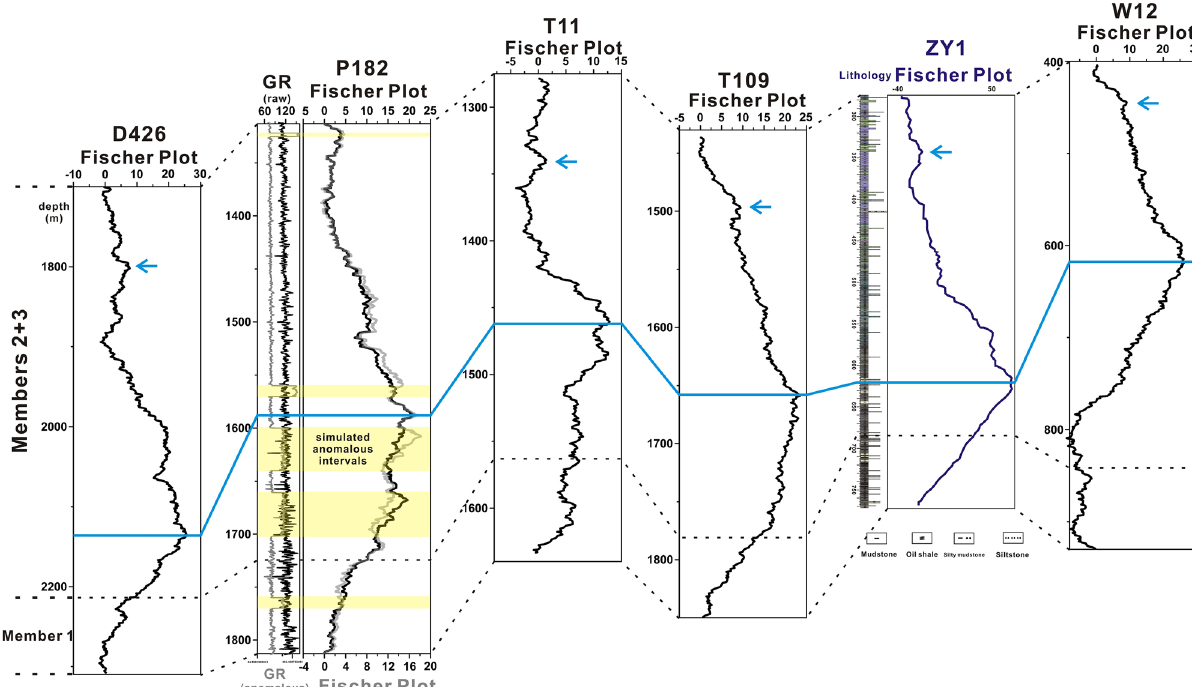
Figure 7. Comparison of Fischer plots constructed by conventional method and the PyFISCHERPLOT code. Sampling positions are shown in Fig. 4. The Fischer plot of Well ZY1 (purple curves) was constructed by cycles manually picked from the core 50 . The other Fischer plots (black curves) are constructed using GR logs by PyFISCHERPLOT. The simulated anomalous GR signal and corresponding Fischer plot of Well P182 are painted in gray and the yellow intervals stand for the abnormal